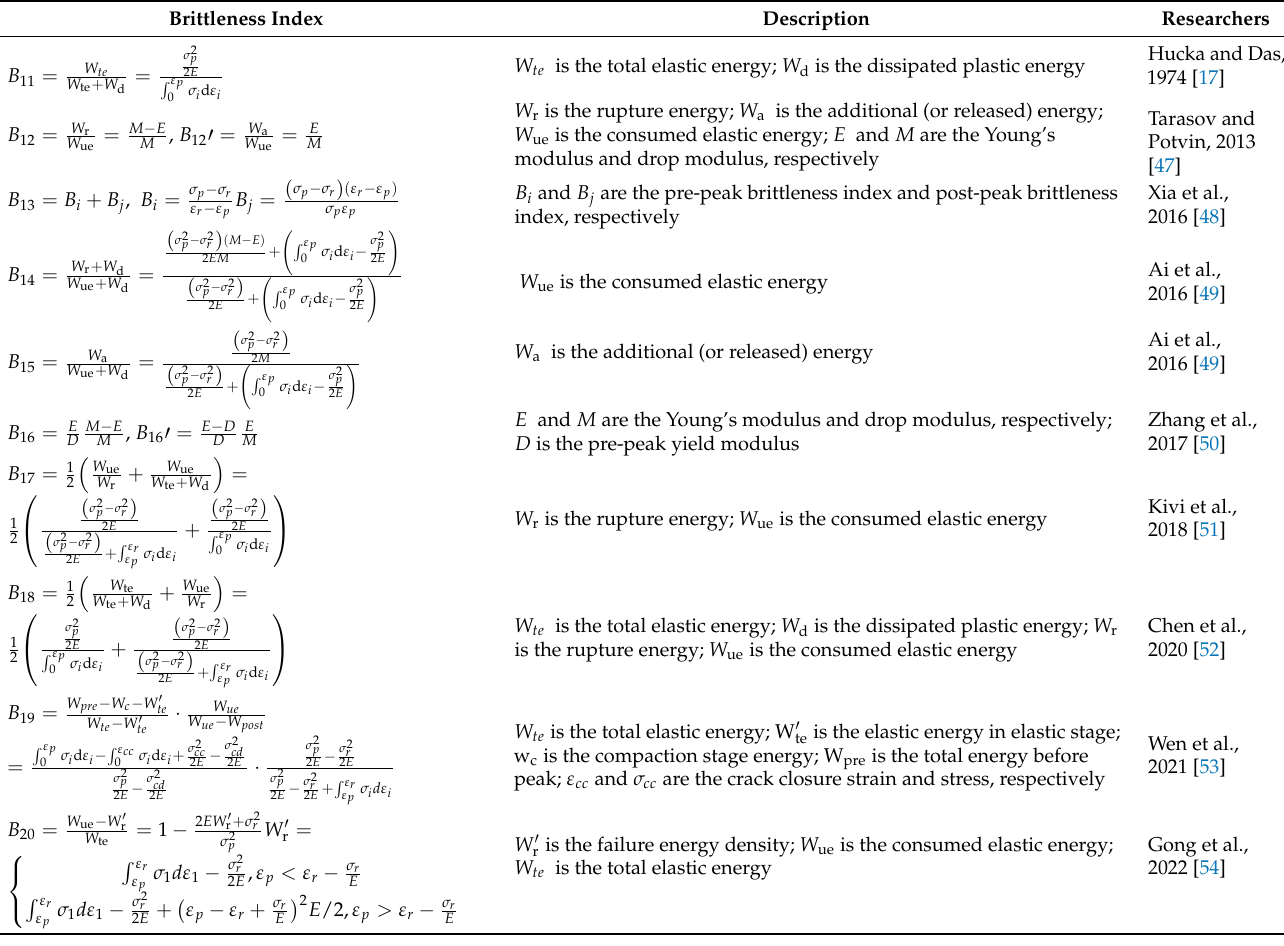
Table 2. Brittleness indexes based on stress–strain curves and energy